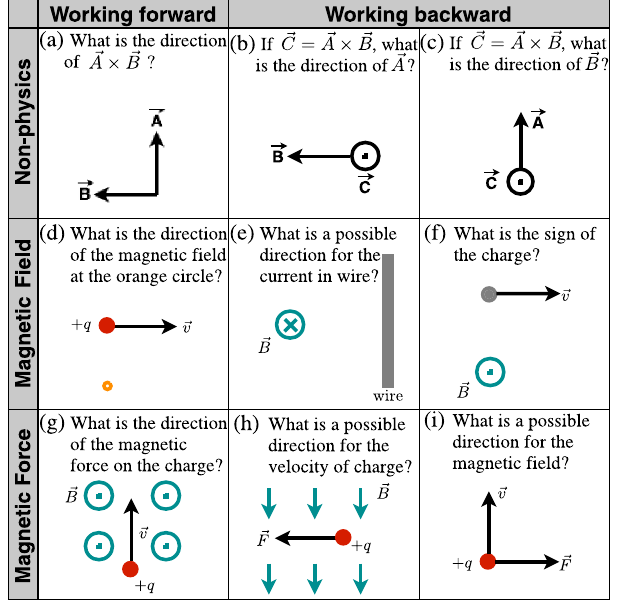
FIG. 2. Examples of Nonphysics (row 1), Magnetic Field (row 2), and Magnetic Force (row 3) questions where the problem involves working Forward (column 1) and working Backward (columns 2 and 3). Problem statements for rows 2 and 3 have been abbreviated for